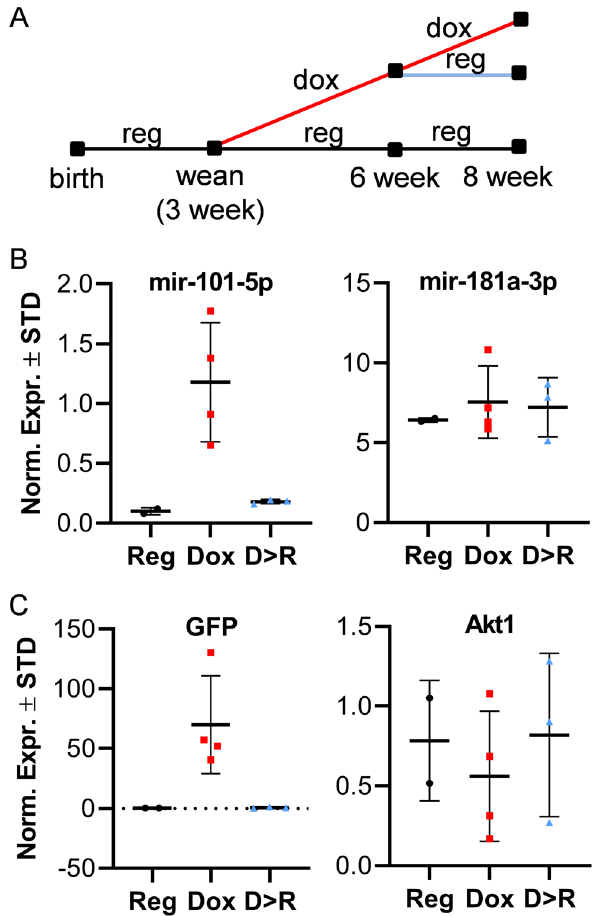
Figure 4. In vivo induction of miR-101a is reversible. Three-week-old R26/101a male mice were fed regular (reg, R) or doxycycline-supplemented diet (dox, D) to assess the reversibility of miR-101a induction in vivo. Schematic representation of the mouse feeding regiment beginning at three and ending at eight weeks of age ( A ). Expression of miR-101-5p and miR-181a-3p ( B ) as well as GFP and Akt1 ( C ) in femora of eight-week- old mice (n = 2 to 4); miR-181a was arbitrarily included as a representative miRNA with a different expression pattern to reflect selectivity in the upregulation of miR-101-5p. MiRNA expression levels are presented using miR-103a-3p as internal control for